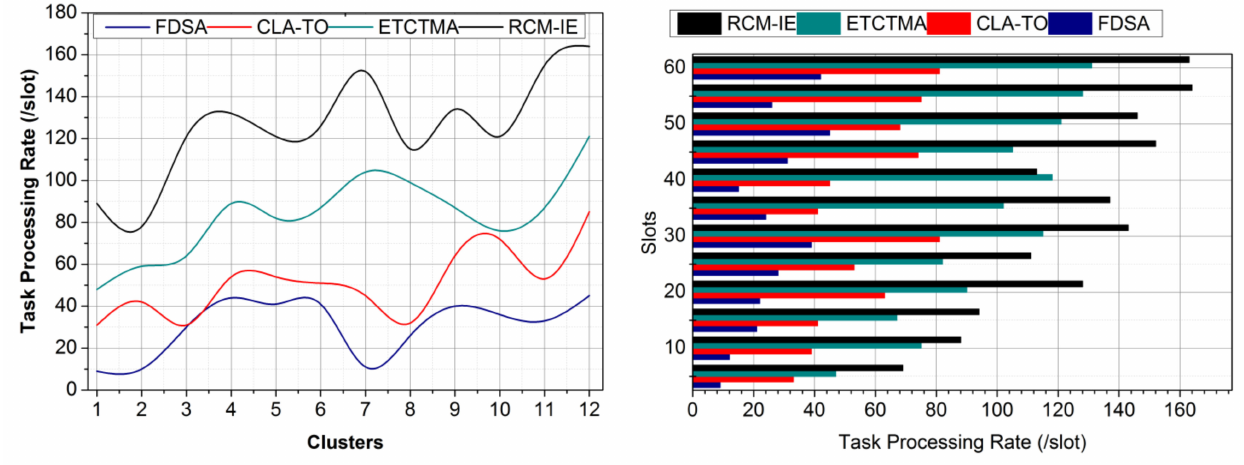
Figure 9. Task processing